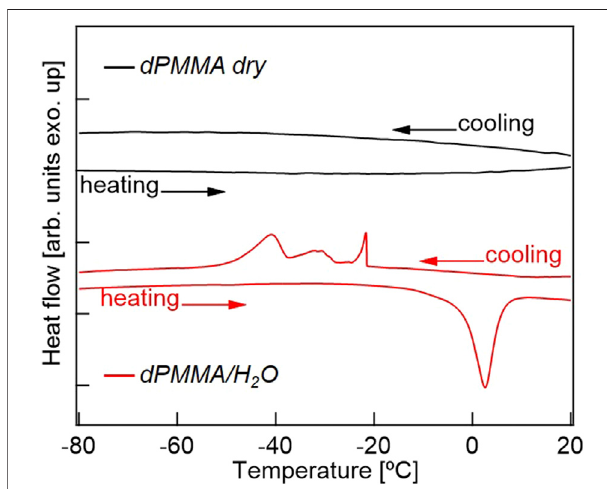
FIGURE 7 | DSC thermograms for dPMMA in its dry and hydrated states.